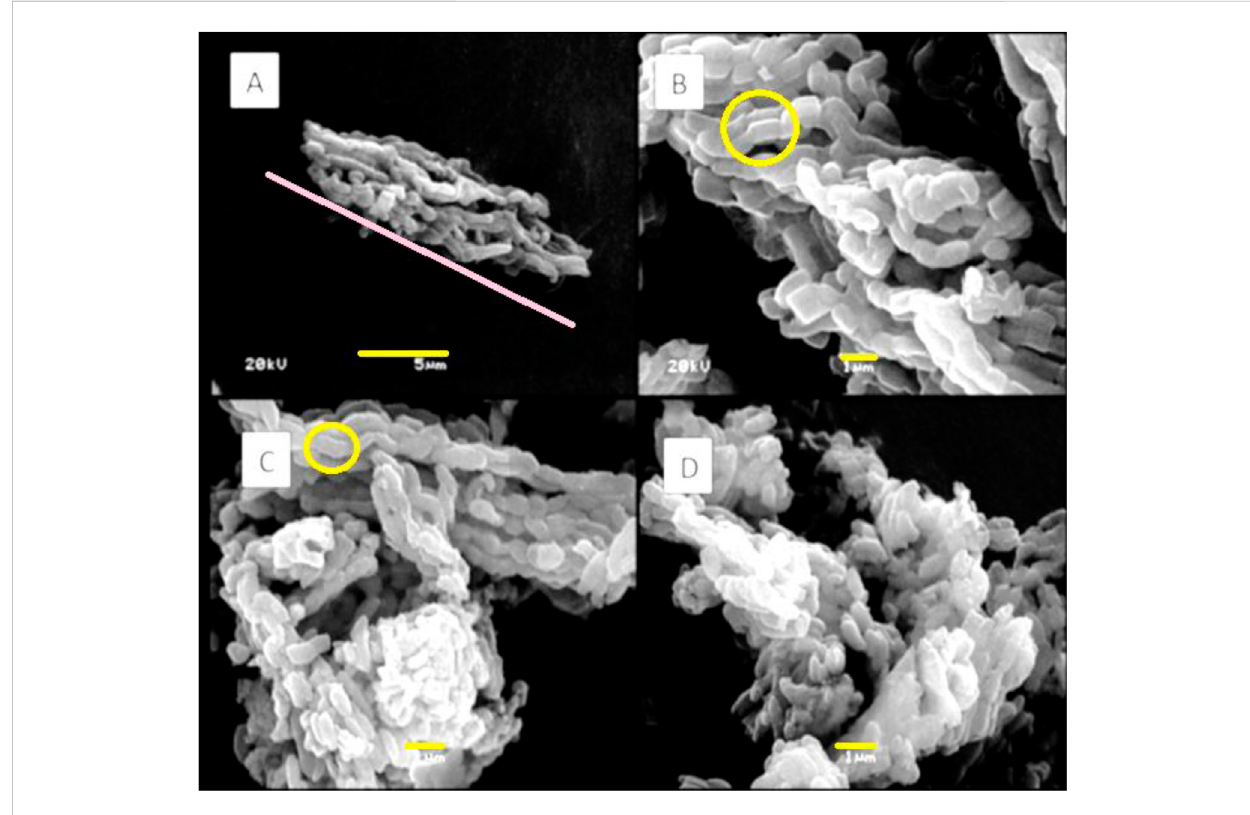
FIGURE 6 SEM micrographs of (A,B) SBA-15 with different magni fi cations (C) SBA@N and (D) SBA@3N, scale bar 1 μ m and 5 μ m, and magni fi cations ×10,000 and ×3,500.